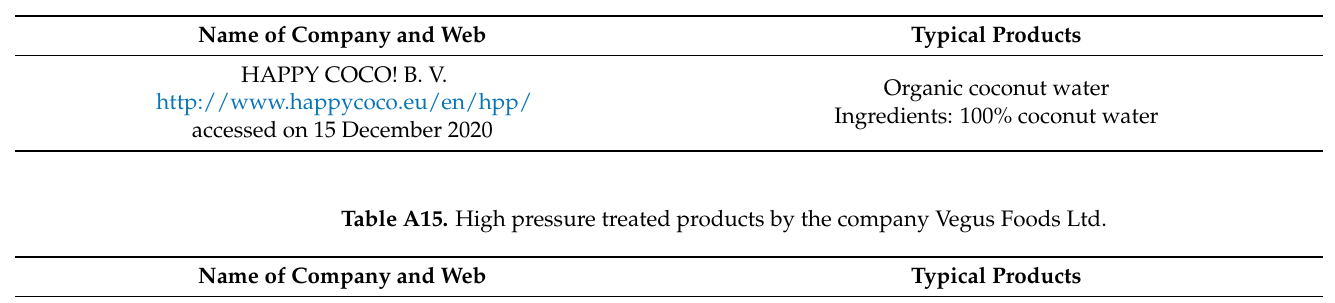
Table A14. High pressure treated products by the company HAPPY COCO! B. V.